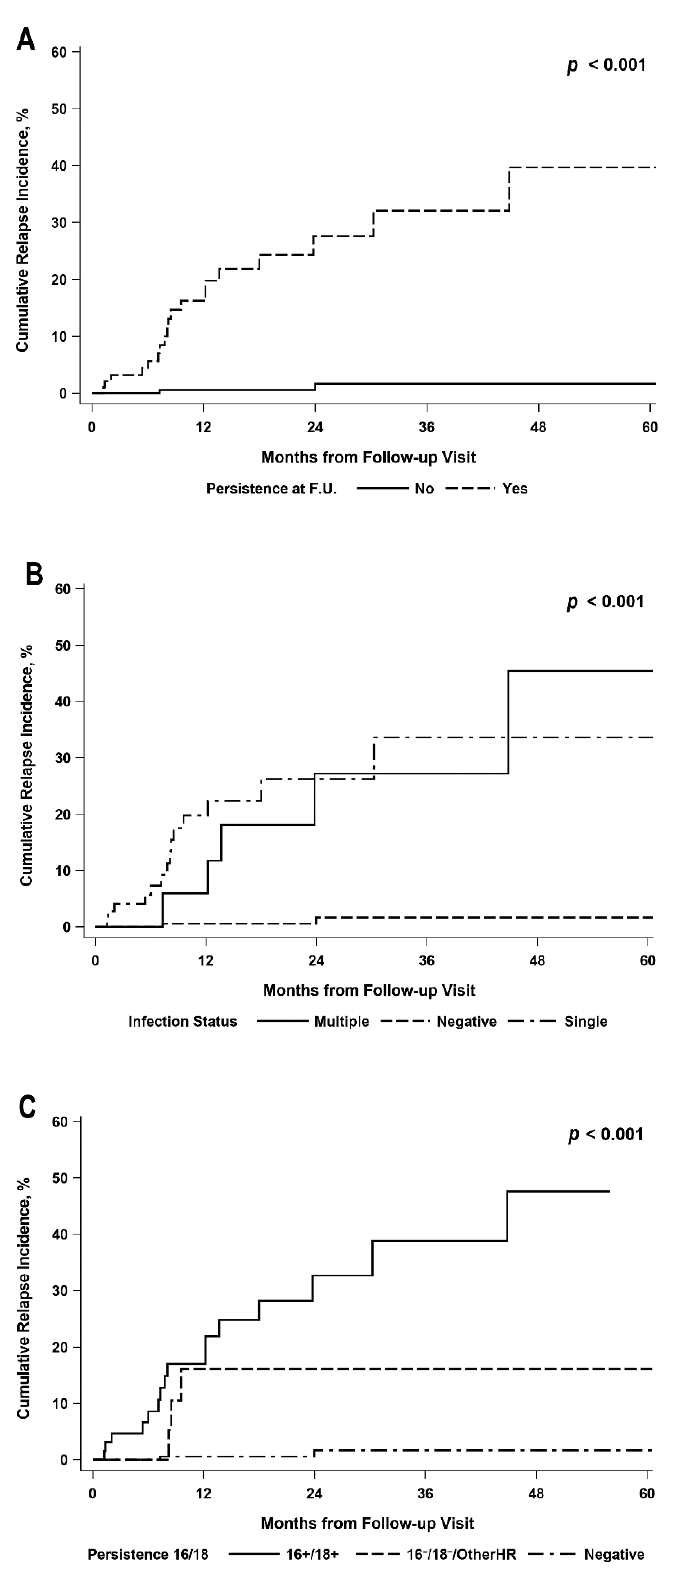
Figure 3. Cumulative relapse incidence by HPV status at first F.U. visit, specifically by HPV infection persistence ( A ), persistence of single or multiple infections ( B ) and persistence of HPV 16/18 or other HR HPV genotypes ( C ). F.U. = follow-up, HR = High-Risk.